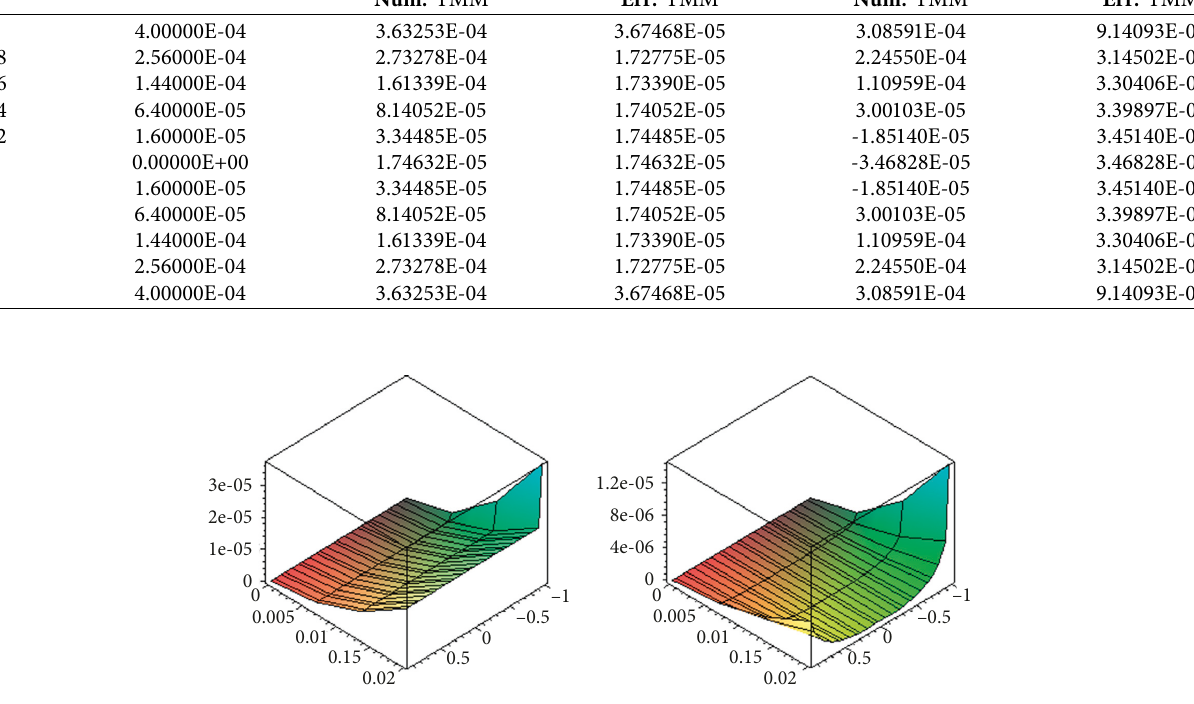
Table 1: Describes the numerical solution of (41) with Carleman kernel and the corresponding error. x